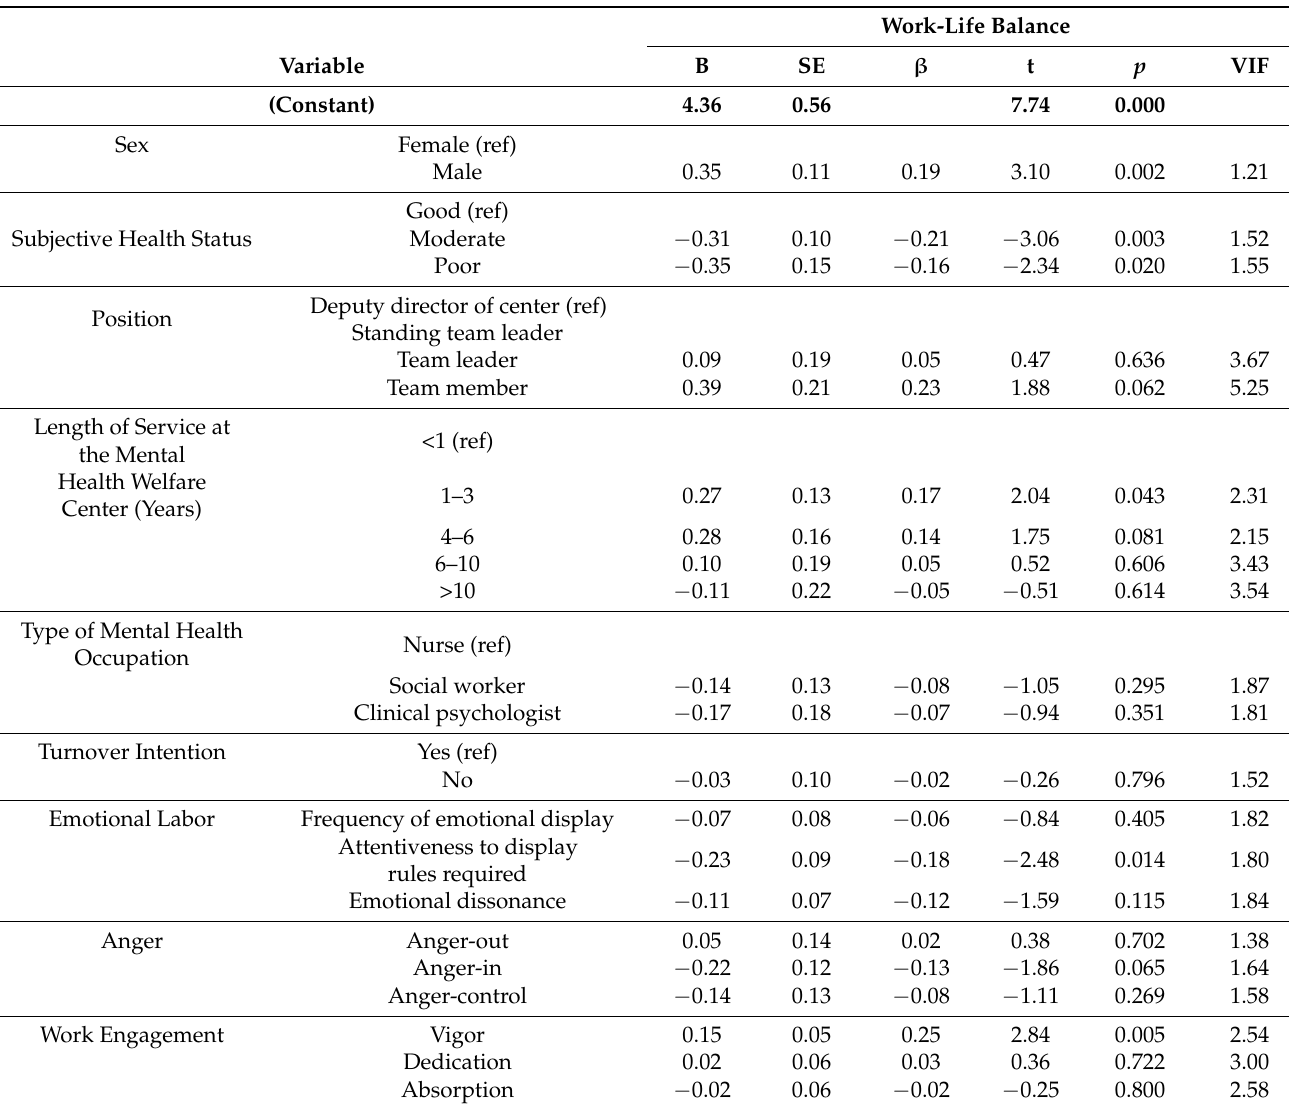
Table 4. Factors Influencing Work-Life